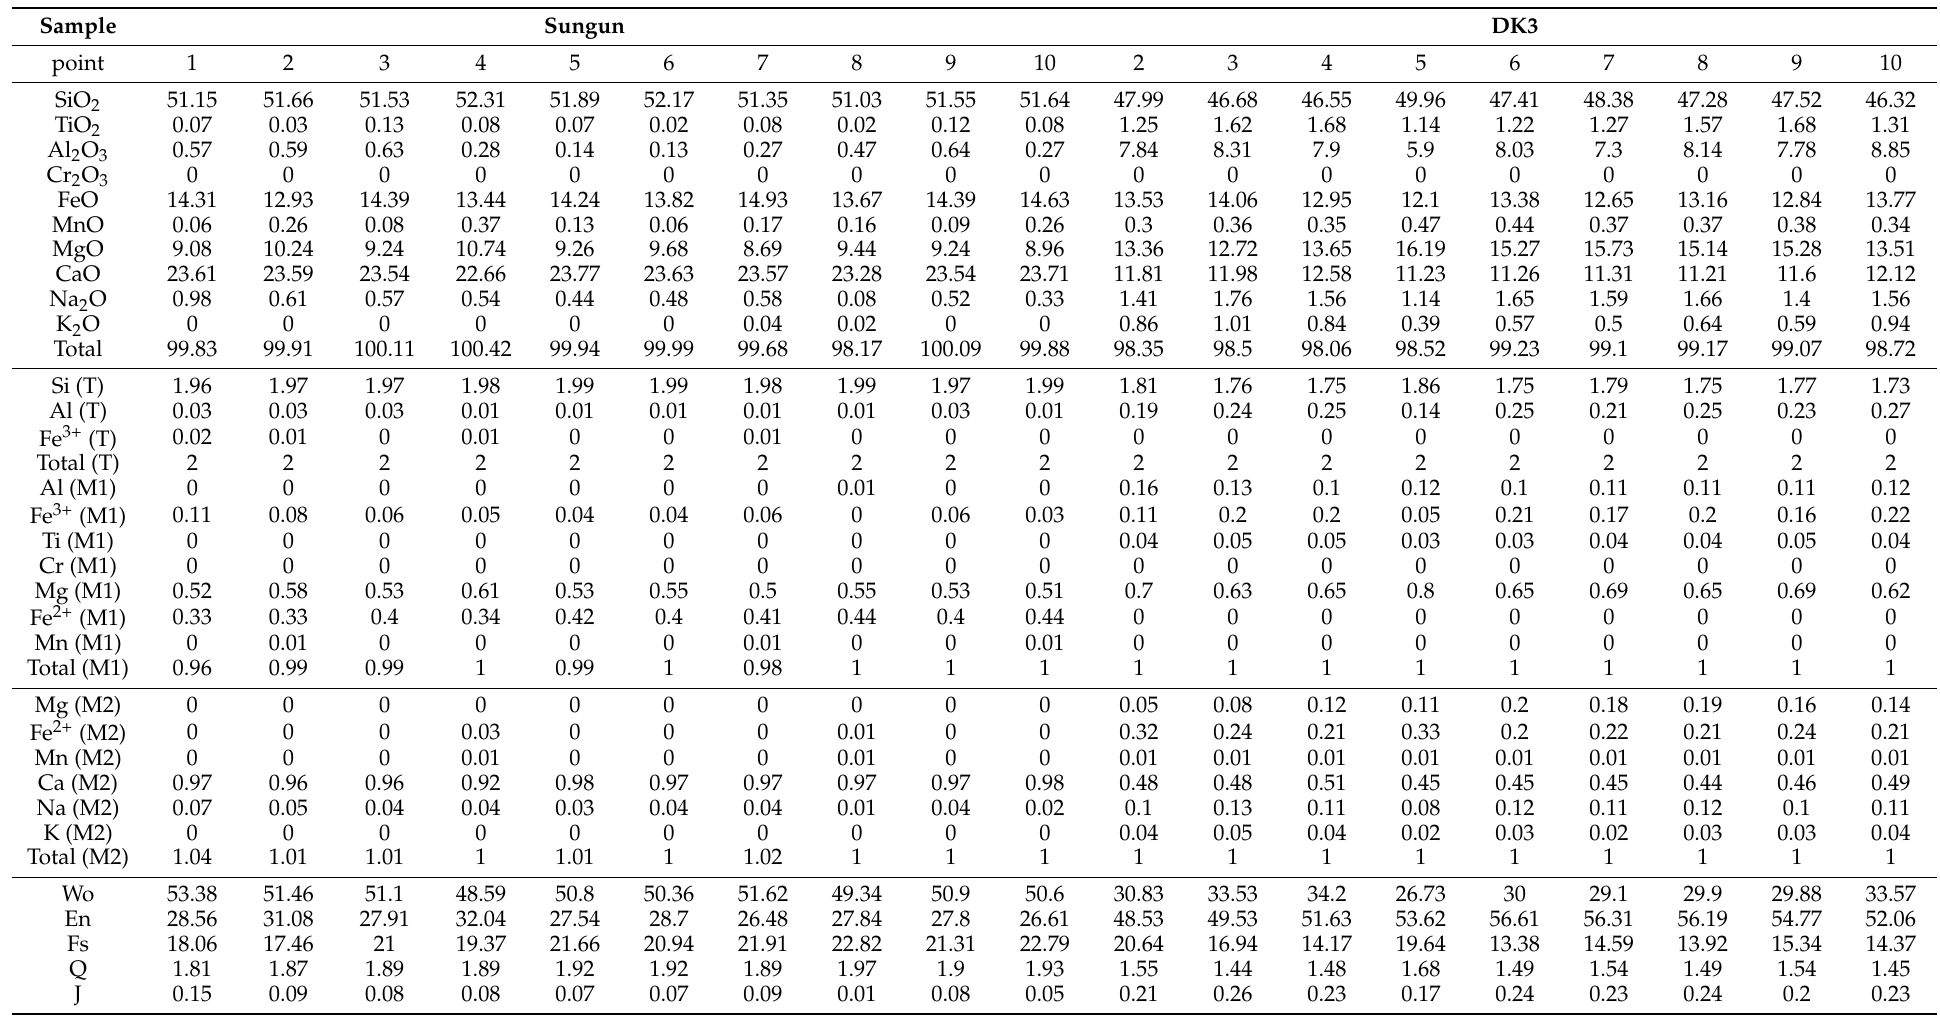
Table 4. EPMA analysis results of pyroxene of diorite dyke and Sungun skarn [26] (chemical composition of pyroxenes and structural formula based on 6 oxygen